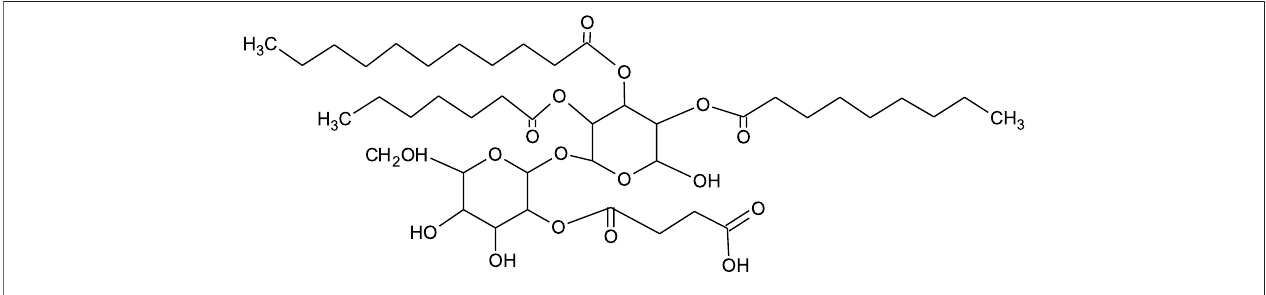
FIGURE 3 | Chemical structure of trehalolipid from Rhodococcus sp. (Ortiz et al.,